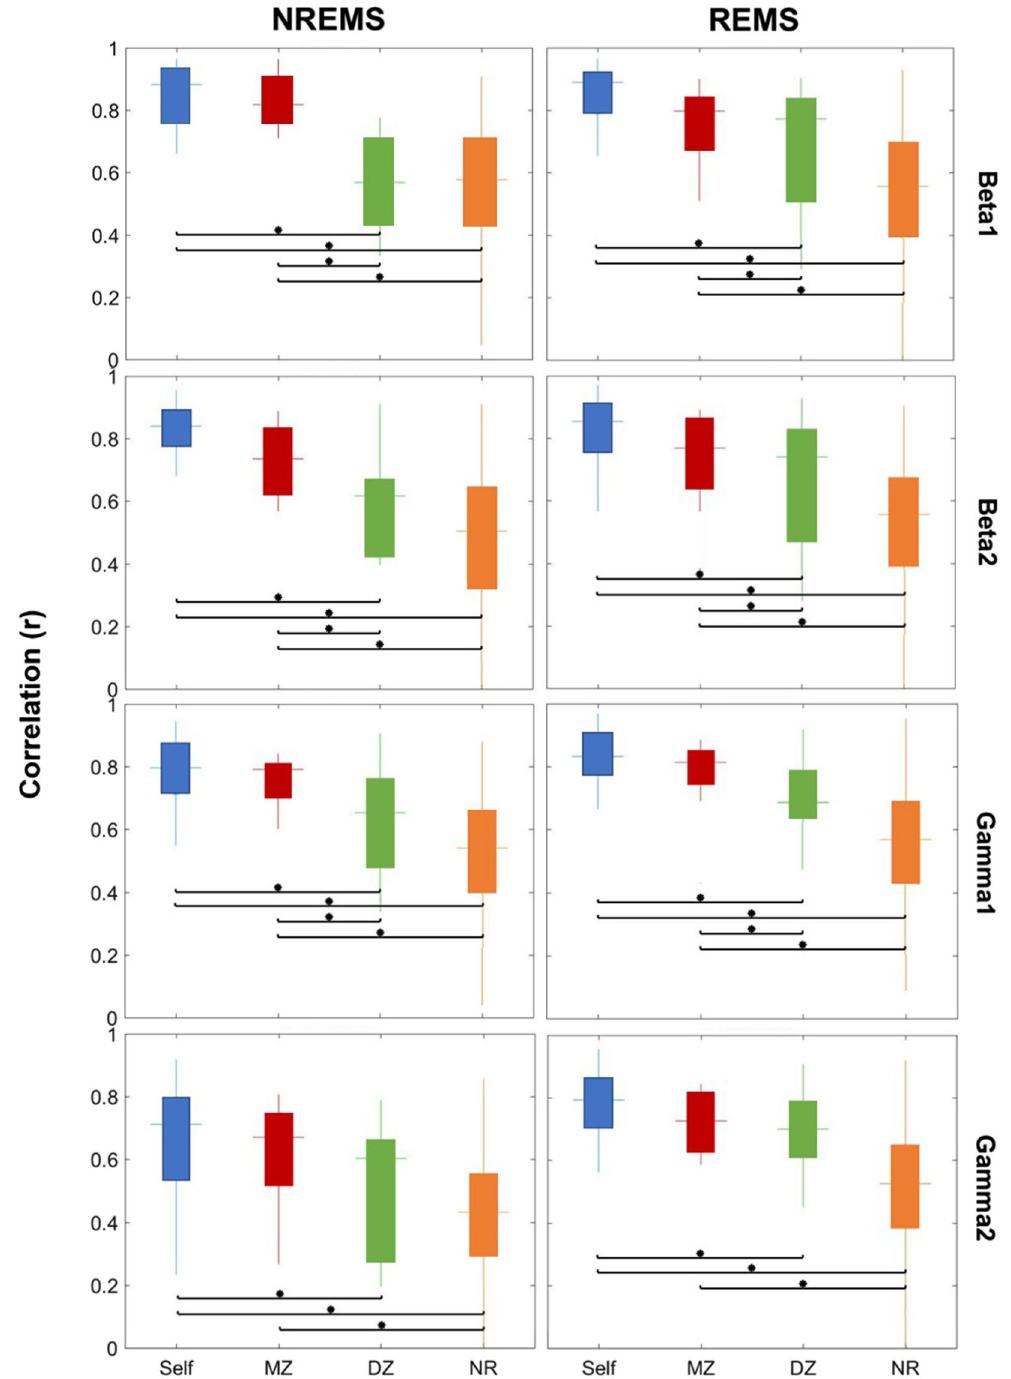
Figure 3. Box plots of correlation coefficients within each group, for the frequency bands beta 1, beta 2, gamma 1 and gamma 2, and the two states, NREMS and REMS. The bottom and top edges of each box indicate the first and third quartiles, the central line indicates the median, and the maximum whisker length is defined as 1.5 times the interquartile range, ending at the maximum value in this range. Differences between the groups were evaluated by means of Tukey-corrected post-hoc t-tests on Fisher’s z-transformed values. The significant differences (p < 0.05) are depicted with an